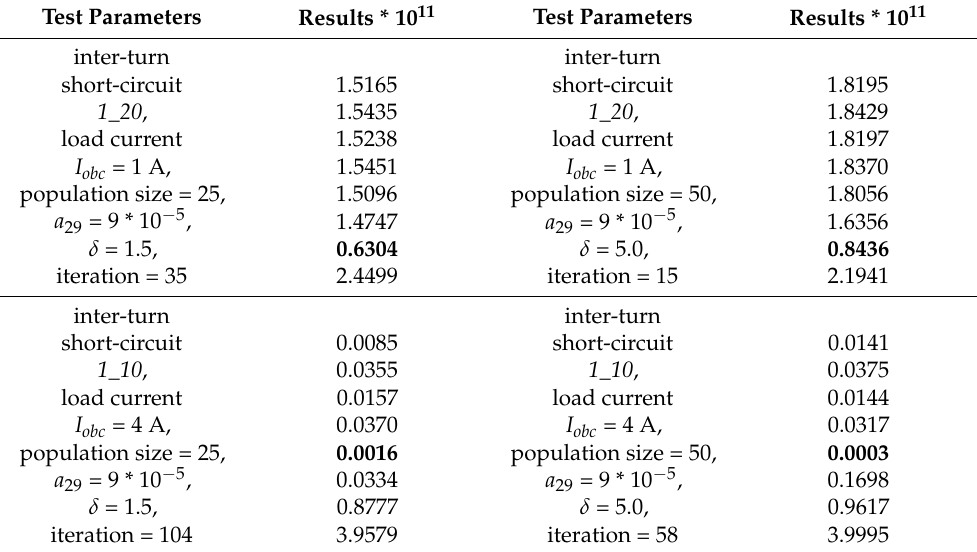
Table 1. Example results of H 1 matrix for electromagnetic torque m el .